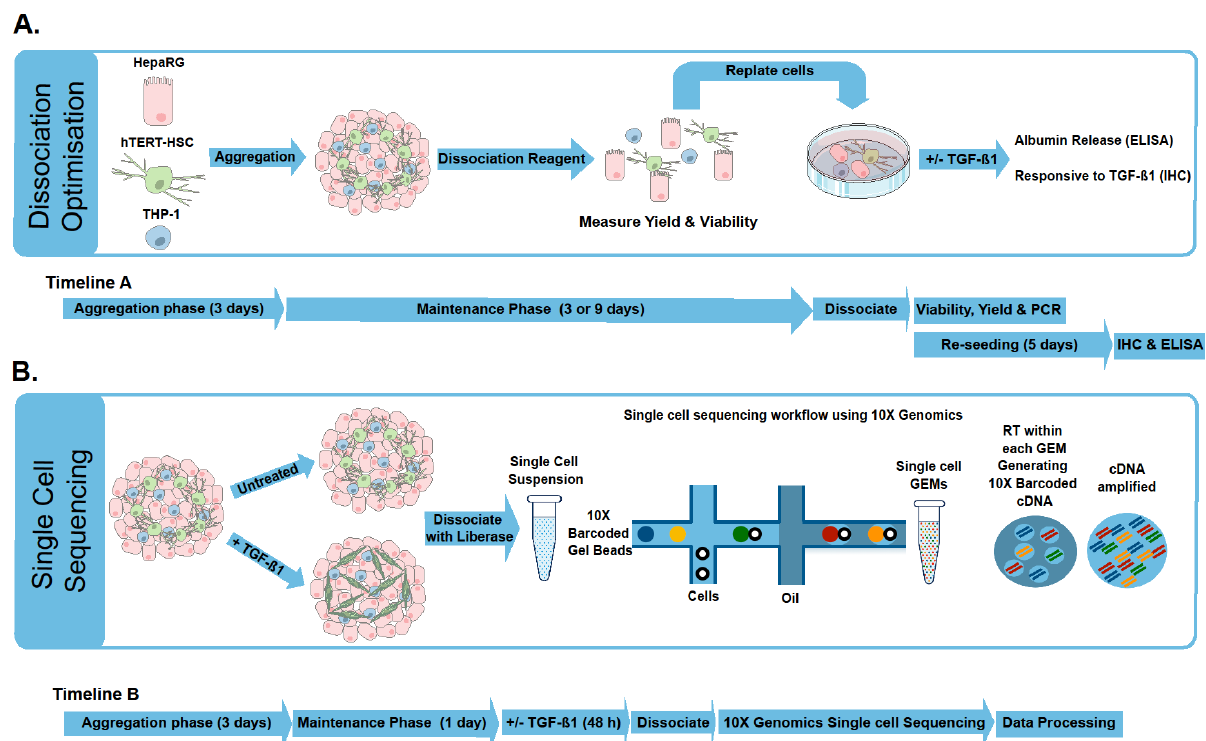
Figure 1. Graphical representation of experimental methodology with corresponding timelines. Human liver microtissues (MTs) are generated using HepaRG, hTERT-HSC, and THP-1. Initial experiments focused on optimization of dissociation using Liberase, Accutase and Accumax by comparing yield and viability. After dissociation, cells were suspended in 96 well plates to assess the maintenance of crucial cellular characteristics: HepaRG were able to release albumin; hTERT-HSC were able to become activated upon exposure to TGF- β 1 ( A ). The optimized dissociation protocol was used to dissociate TGF- β 1 treated and untreated MTs for processing following the single cell sequencing workflow ( B